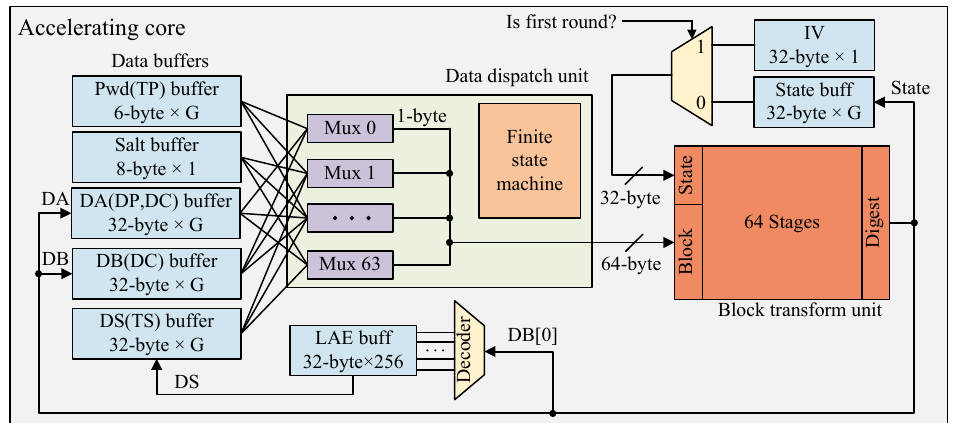
Figure 15: The detailed architecture of the accelerating